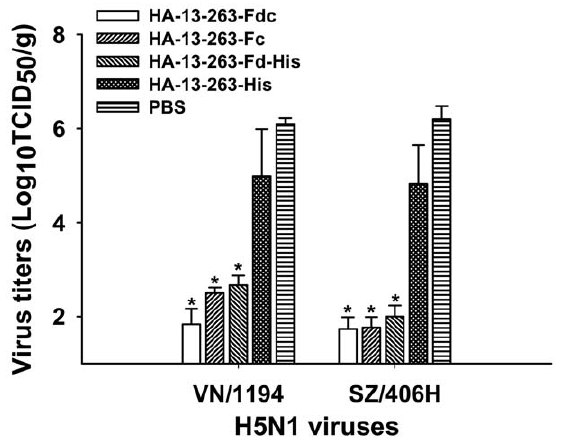
Figure 9. Comparison of viral titers in virus-challenged lung tissues of mice vaccinated with HA-13–263 proteins. Viral titers of VN/1194 (clade 1) and SZ/406H (clade 2.3.4) H5N1 viruses were determined in the lung tissues of the mice vaccinated with HA-13–263 proteins, respectively, collected on 5 day post-challenge. Mice injected with PBS were used as the negative control. * indicates significant difference ( P , 0.05), respectively, between HA-13–263-Fdc, HA-13–263- Fc, or HA-13–263-Fd-His vaccination groups and HA-13–263-His or PBS control group. The data are expressed as mean 6 SD of viral titers 50% tissue culture infective dose (Log 10 TCID 50 /g) of lung tissues from five mice per group. The limit of detection is 1.5 Log 10 TCID 50 /g of tissues.